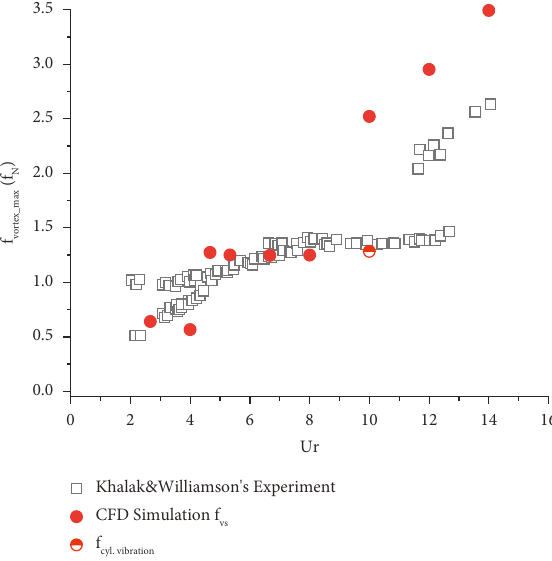
Figure 10: Frequency response through the lock-in regime.